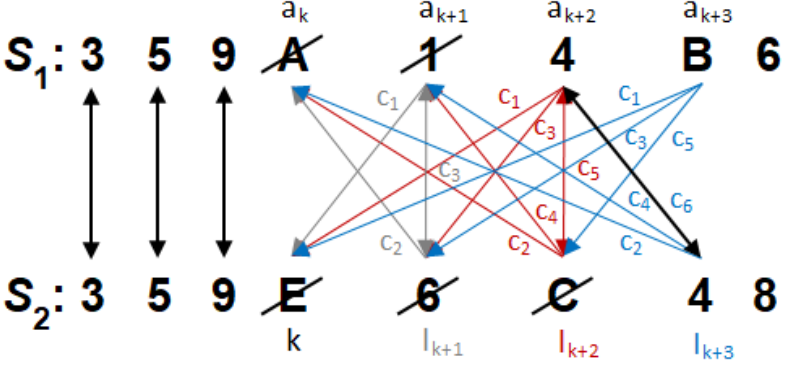
Figure 3. An example of the operation of the algorithm—matching common elements and removing